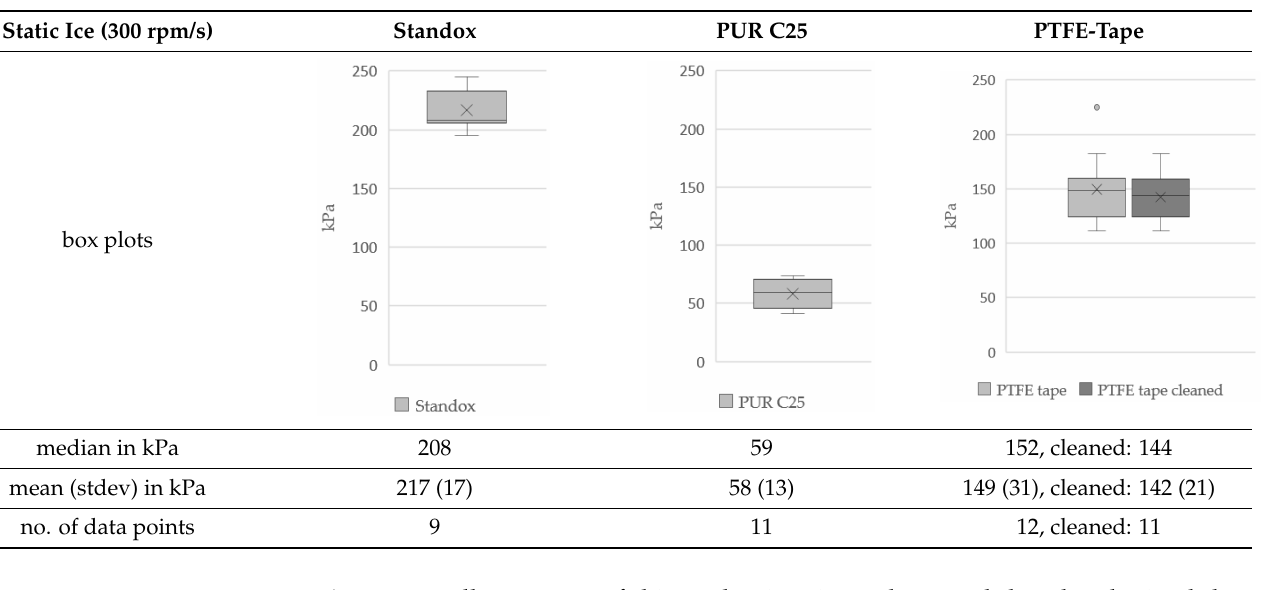
Table 10. Ice adhesion centrifuge test results for static ice (300 rpm/s) with relevant statistical data for result evaluation (given “cleaned” values based on outlier replacements after box plot